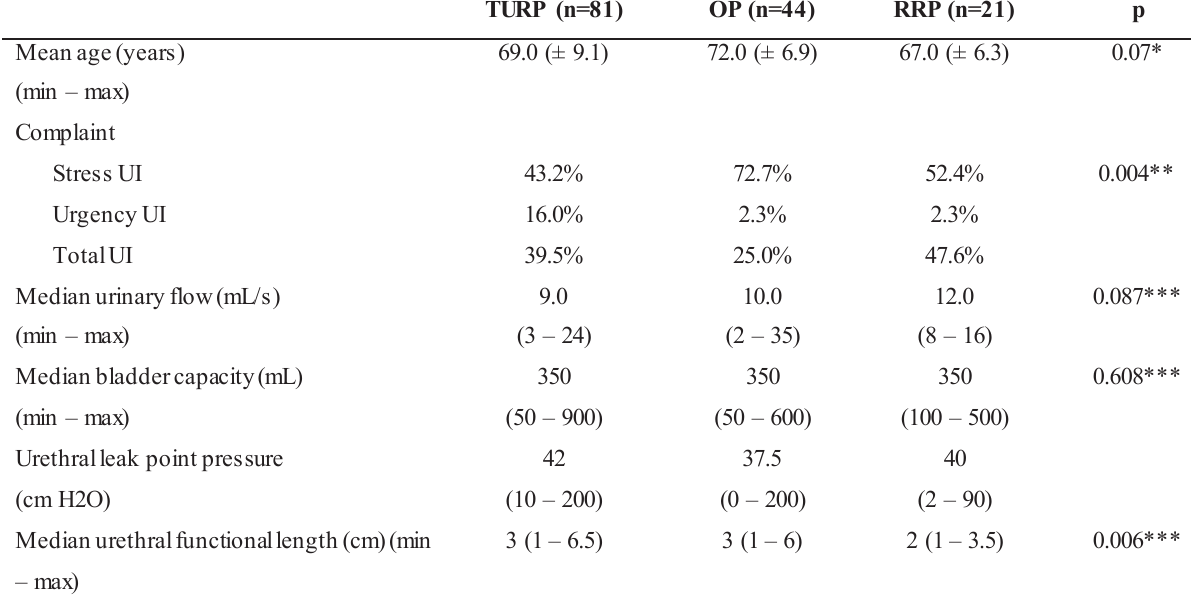
Table 1 - Characteristics of the patients according to the type of surgery.